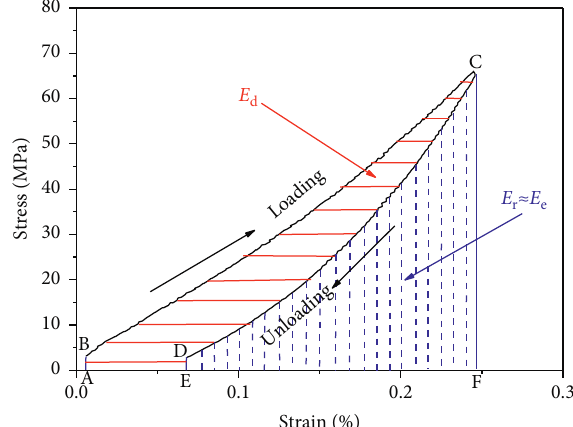
Figure 9: Schematic diagram of energy calculation during one cyclic loading and unloading.